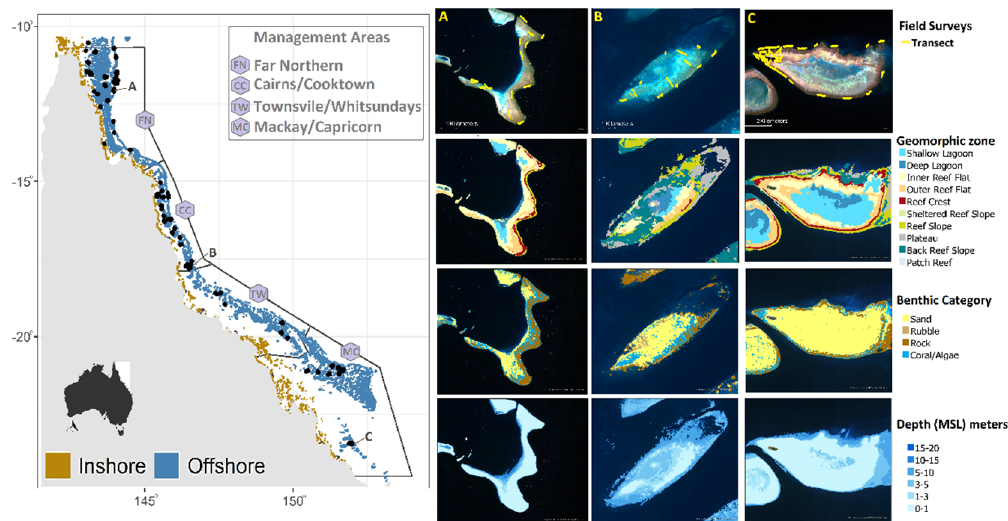
Figure 1. Shallow offshore GBR reefs (in blue) across GBRMPA management regions. Locations with field data (black dots) used for map calibration and validation. Sentinel-2 imagery of Wishbone Reef ( A ), Potter Reef ( B ) and Heron Reef ( C ) indicating the location of transects, geomorphic zonation map, benthic category map and derived depth (bathymetry). See Supplementary Materials Table S1 for definitions of mapping categories based on Reference [52].